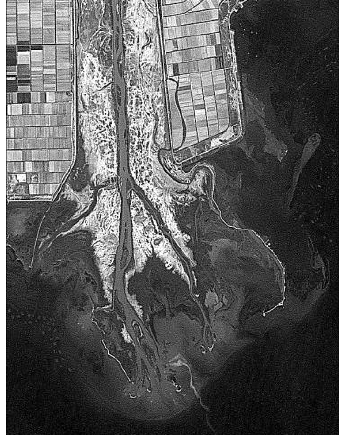
Figure 4c. Axios delta – 3x3 high pass filter